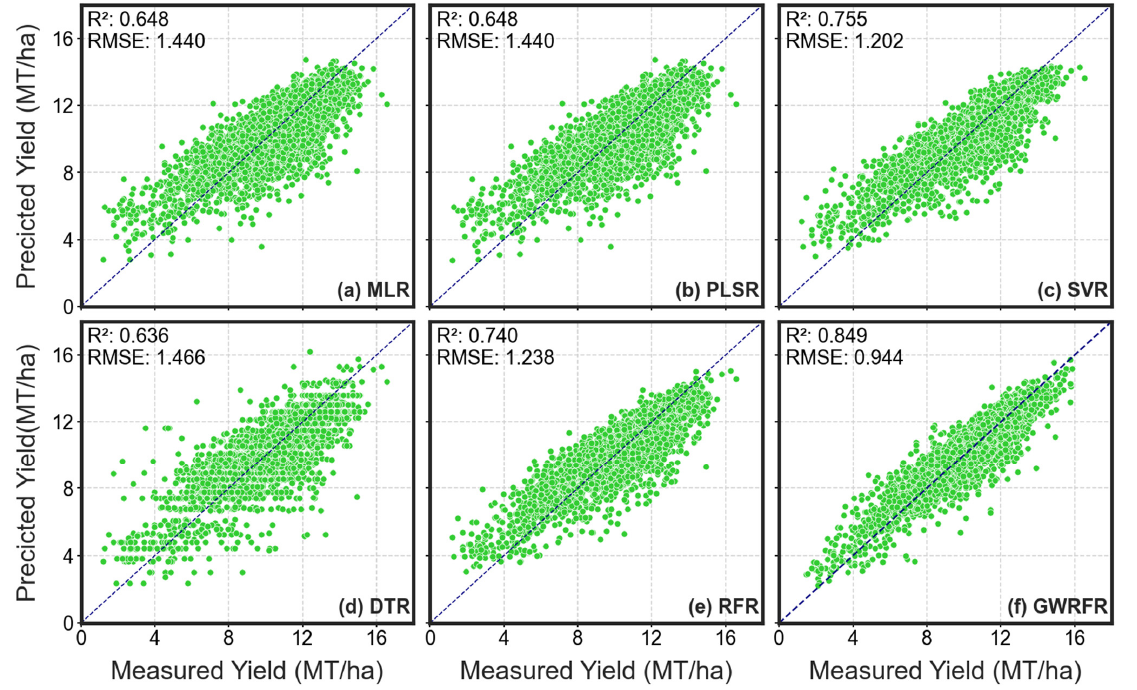
Figure 6. The scatterplots of the actual yield and the predicted yield derived from ( a ) MLR, ( b ) PLSR, ( c ) SVR, ( d ) DTR, ( e ) RFR, and ( f ) GWRFR using only vegetation indices derived from RS data.